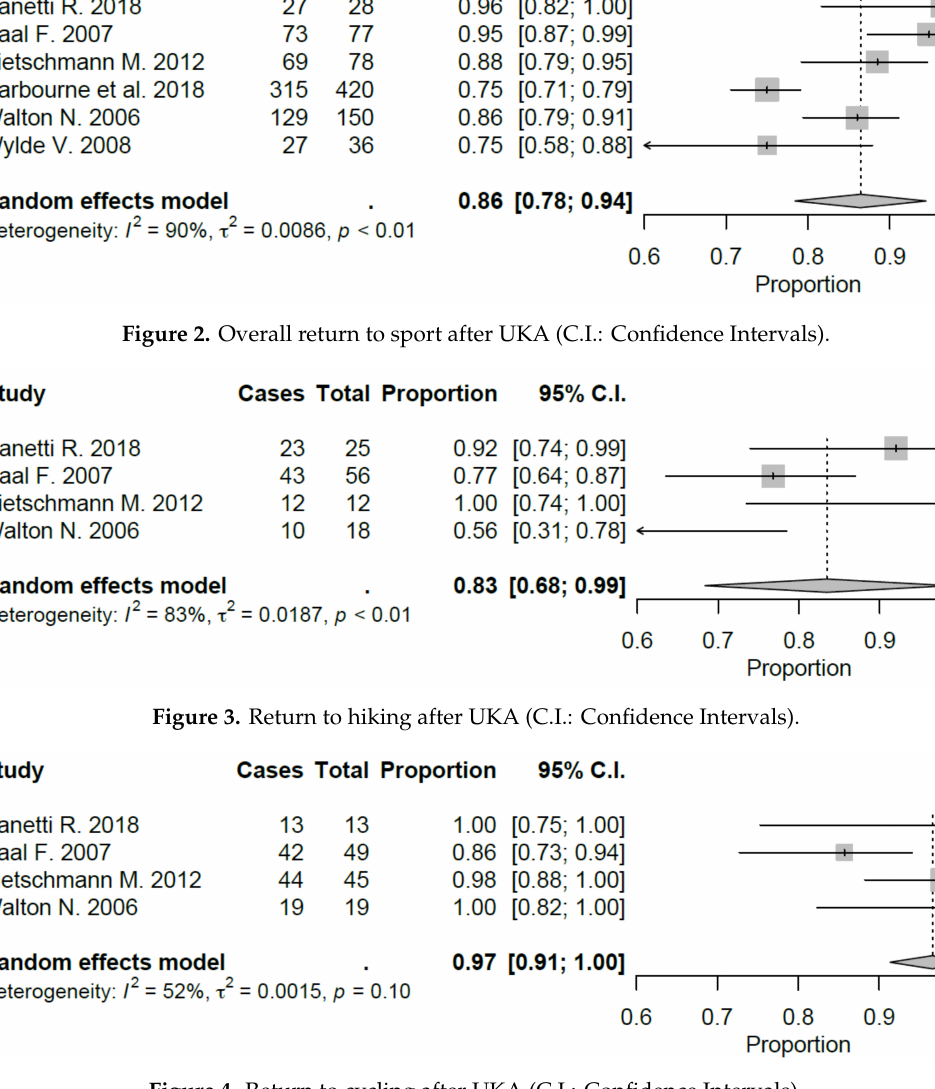
Figure 4. Return to cycling after UKA (C.I.: Confidence